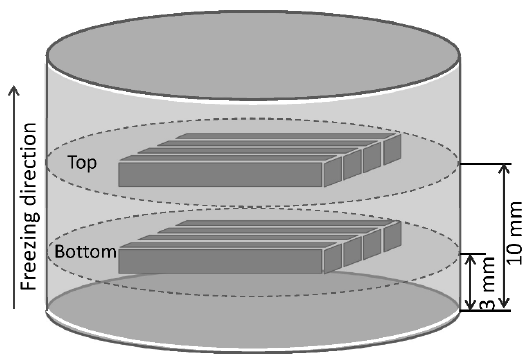
Figure 1. Schematic illustration of the locations from where the mechanical testing specimens were taken.